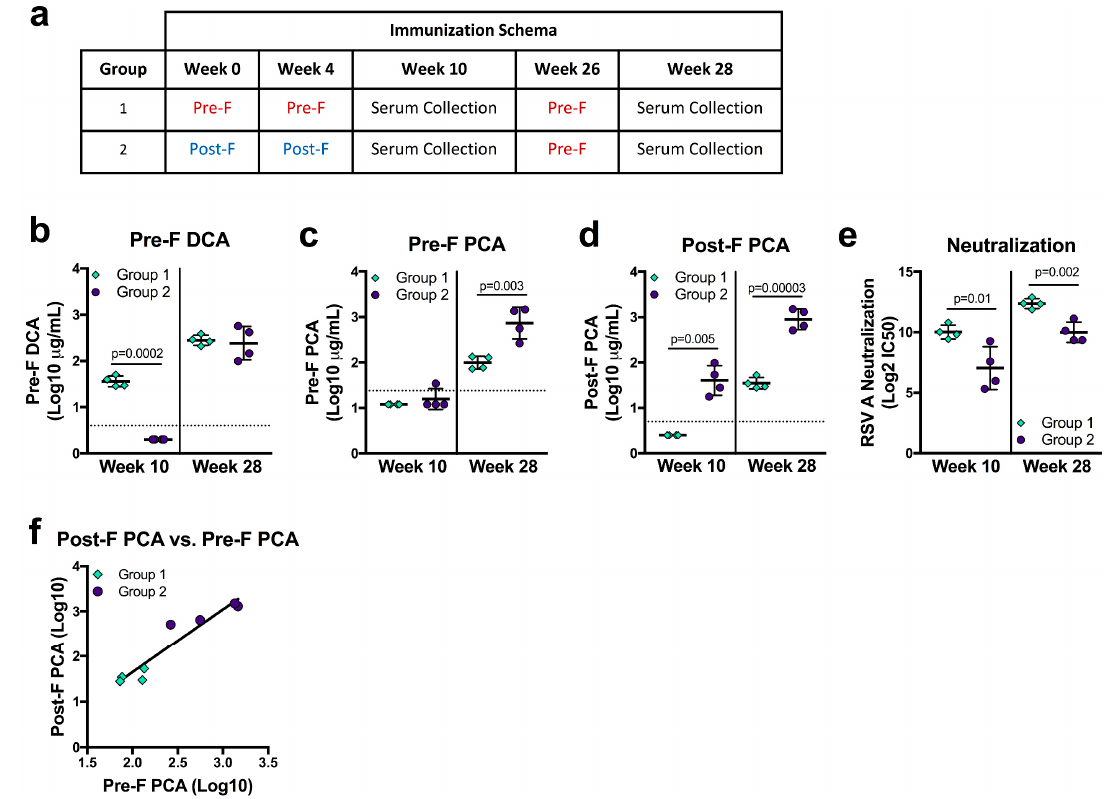
Figure 4. RSV F immune history affects readouts from mAb competition assays. ( a ) Immunization schema and serum collection timepoints for rhesus macaques immunized with 50 µ g/animal of RSV F variant immunogen proteins adjuvanted with poly I:C. ( b – d ) Serum levels of pre-F DCA ( b ), pre-F PCA ( c ), and post-F PCA ( d ) at weeks 10 and 28. The horizontal dotted lines indicate the limit of quantitation for each assay. ( e ) Neutralization activity of sera collected at weeks 10 and 28. ( f ) Correlation of PCA readouts from group one and group two animals two weeks after the third immunization ( r = 0.952, p = 0.001). All results are the average of technical duplicates performed for each